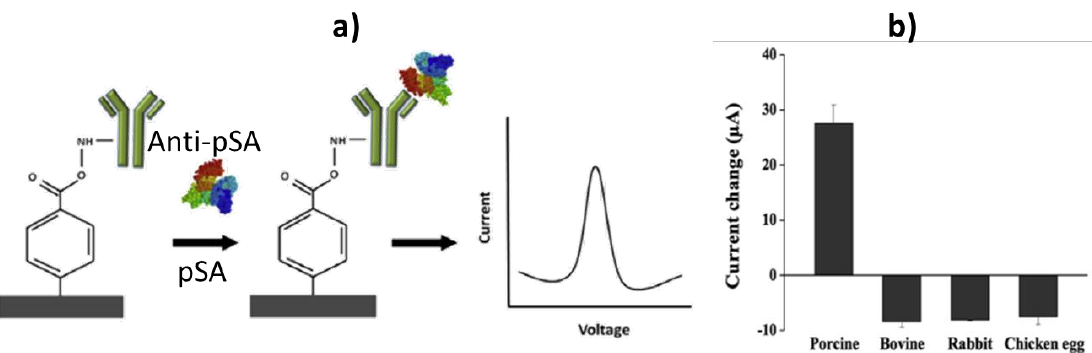
Figure 4. Electrochemical immunosensor developed for pSA determination onto a CNF SPE modified with a 4-carboxyphenyl layer ( a ) and comparison of the DPV responses provided by the immunosensor to 100 pg mL −1 of serum albumin from porcine, bovine, rabbit and albumin in chicken egg ( b ). Reprinted and adapted from [61] with permission.